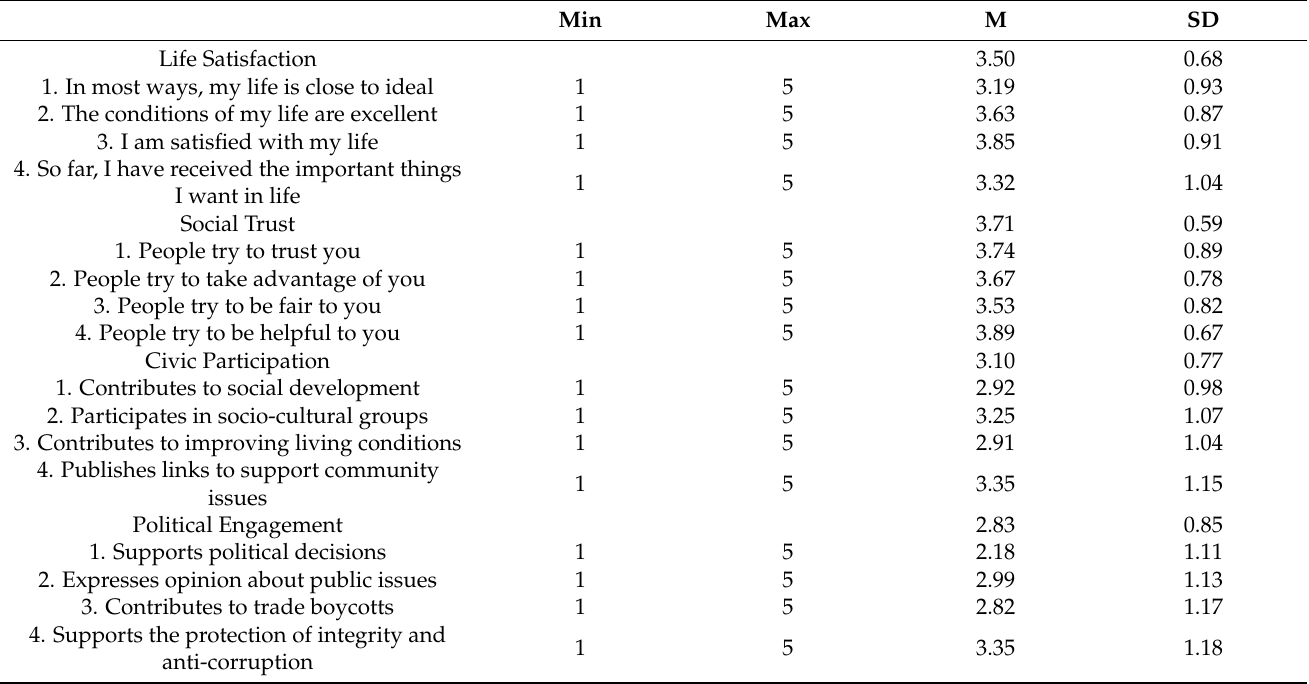
Table 3. Descriptive statistics for scales of social capital and SNSAs.